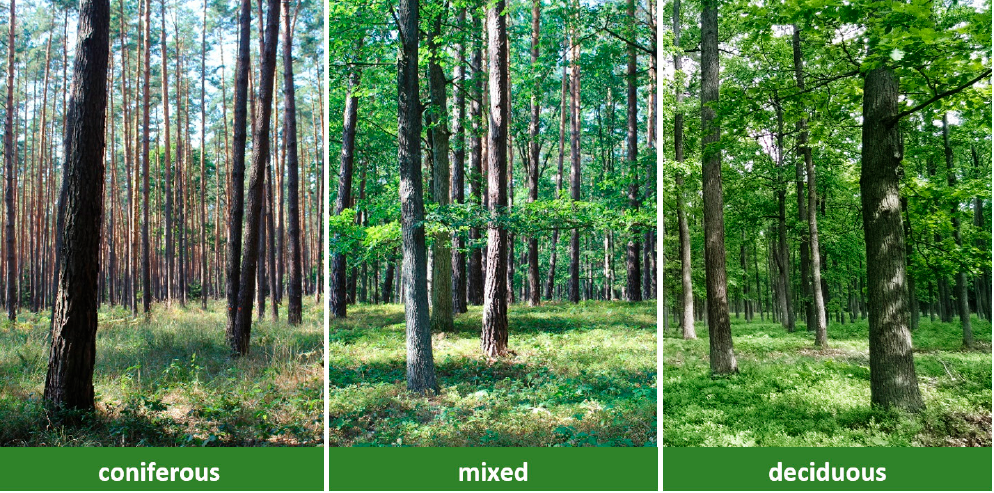
Figure 2. Three types of stands sampled: coniferous ( Pinus sylvestris ), mixed ( Pinus sylvestris and Quercus petraea ), and deciduous ( Quercus petraea ).